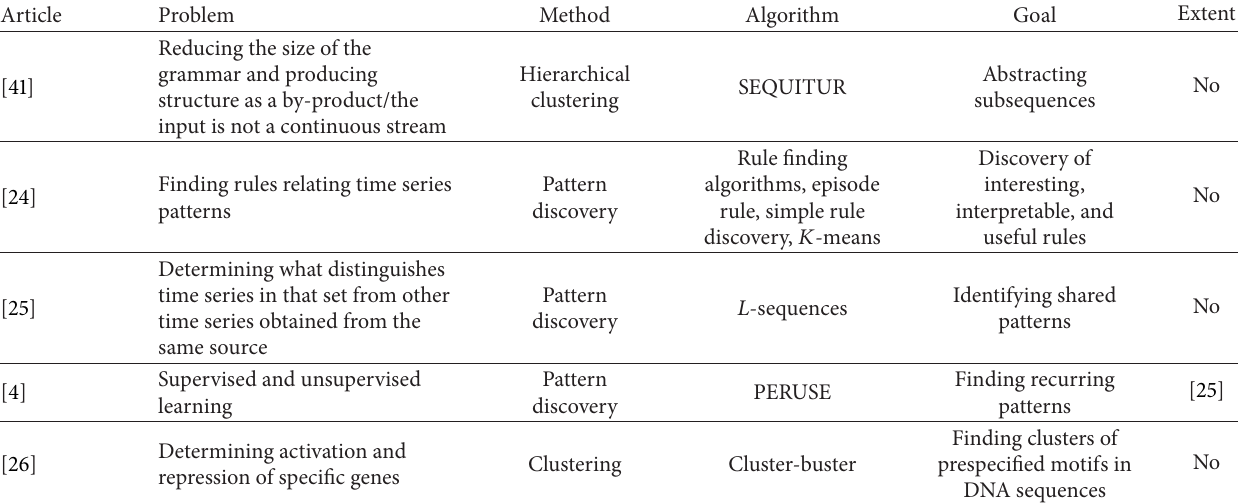
Table 1: The overview of preproof period